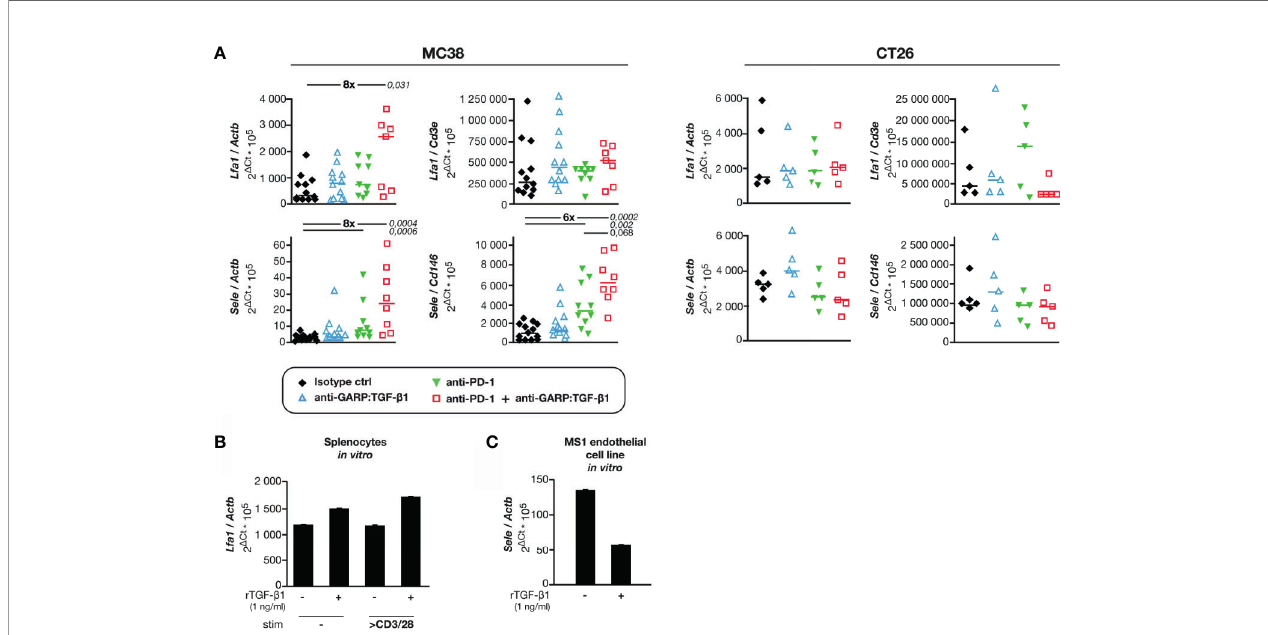
FIGURE 6 | Combined GARP:TGF- b 1/PD-1 blockade increases expression of Sele and Lfa1 in MC38, but not in CT26 tumors. Tumor samples shown in Figure 1C were analyzed by RT-qPCR. (A) mRNA levels of Lfa1 and Sele relative to Actb (housekeeping gene), Cd3e (T-cell speci fi c gene) or Cd146 (endothelial cell-speci fi c gene). Data points represent values in one mouse. Horizontal bars: median per group. P values <0.05, as calculated with a two-sided Wilcoxon test, are indicated in italics. Numbers in bold: fold-change between the indicated groups. (B) Expression of Lfa1 in BALB/c splenocytes exposed to rTGF- b , in presence or absence of anti-CD3/CD28 beads during 24 h in vitro . Bars represent means (+SD) of duplicates. Results from one experiment. (C) Expression of Sele in C166 and MS1 cells exposed to rTGF- b during 24 h in vitro . Bars represent means (+SD) of duplicates. Results from one